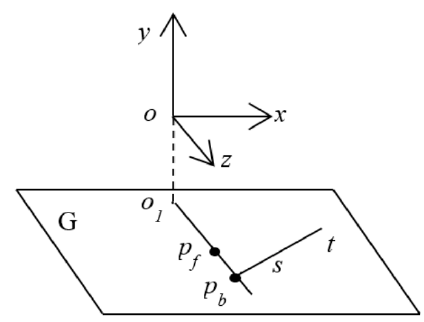
( b ) Figure 4. The tracking trajectories of one person computed using their skeleton (blue line) and shadow (red line), respectively, while they walk along arbitrary directions in the coordinate system of the